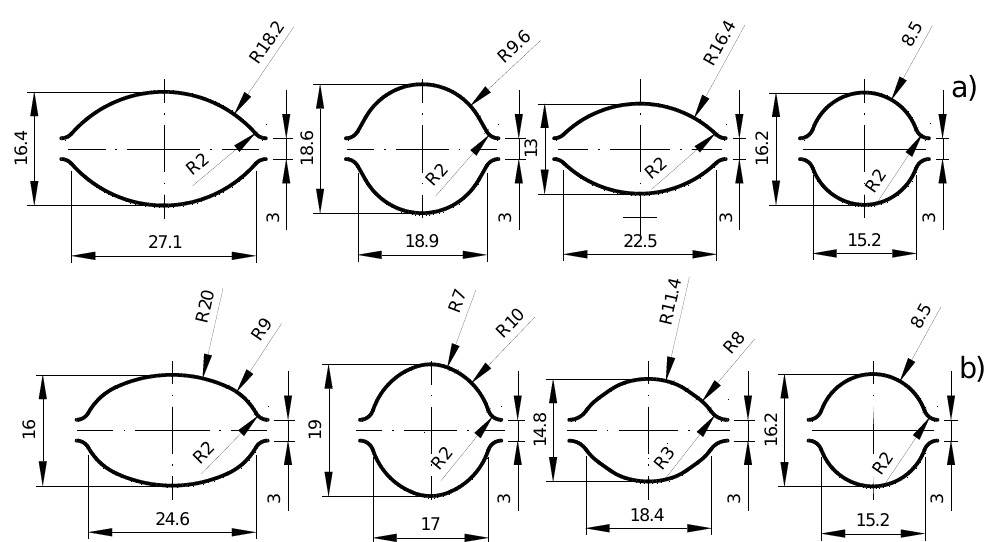
Figure 3. The shape and dimensions of the designed elongating passes: ( a ) classic system (variant I), ( b ) multi-radial modified system (variant II).